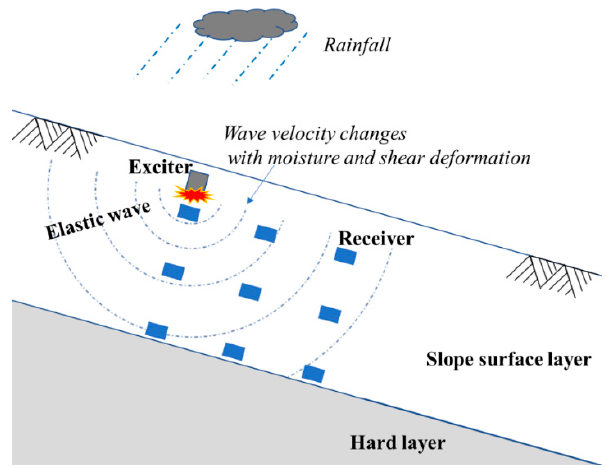
Figure 1. The typical layout of the sensors to determine the soil moisture and shear deformation by elastic wave propagation in a slope surface layer.